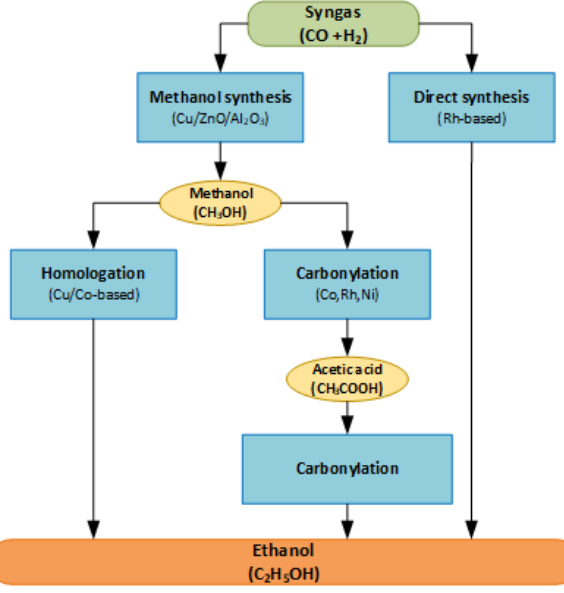
Figure 4. Different thermochemical bioethanol production pathways (adapted from [122]). Figure 4. Di ff erent thermochemical bioethanol production pathways (adapted from